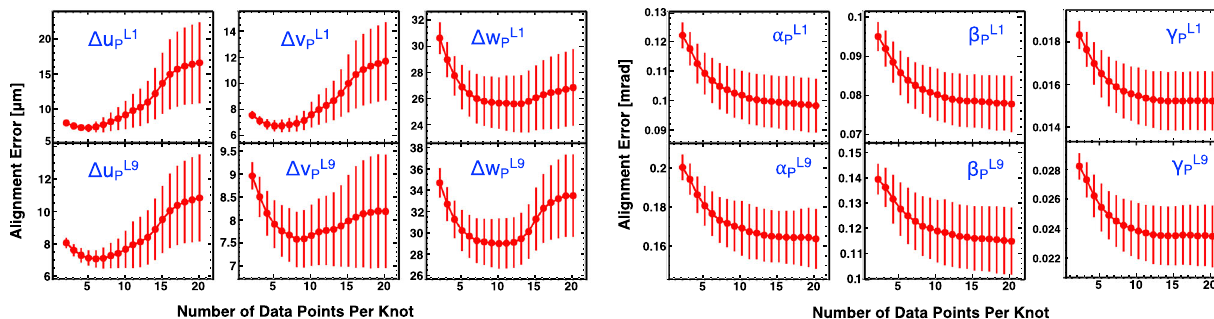
Fig. 14 The total errors of the dynamic alignment parameters as functions of number of data points per knot, calculated over 10 years from Eq. (50). The error bars in each plot represent the standard deviations of the alignment errors arising from the time dependence